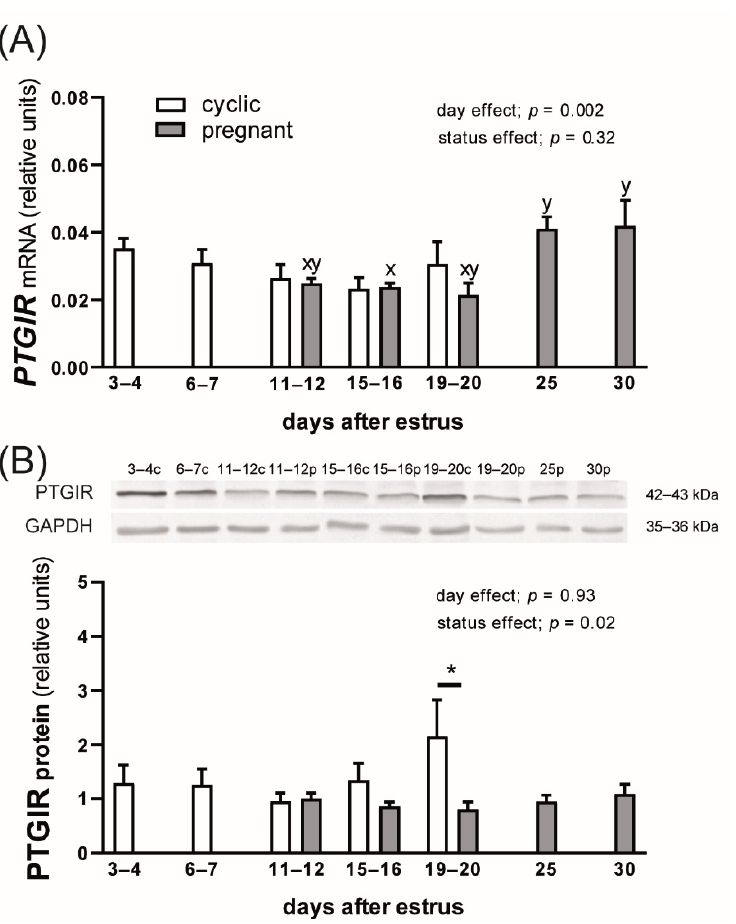
Figure 2. Prostaglandin I2 receptor (PTGIR) mRNA ( A ) and protein ( B ) expression in the myometrium of cyclic and early pregnant gilts. Values from real-time PCR for PTGIR were normalized to geometric averaging of GAPDH and HPRT1 gene expression. Values from densitometric analyses of PTGIR protein were normalized to GAPDH. Representative blots are presented (c—cyclic, p—pregnant; original western blots are included in Figure S1). Data are expressed as the mean ± SEM ( n = 5–7). Bars marked with various letters are different among the group of pregnant females. Asterisk specifies the difference between cyclic and pregnant animals on days 19–20 after estrus (* p < 0.05).